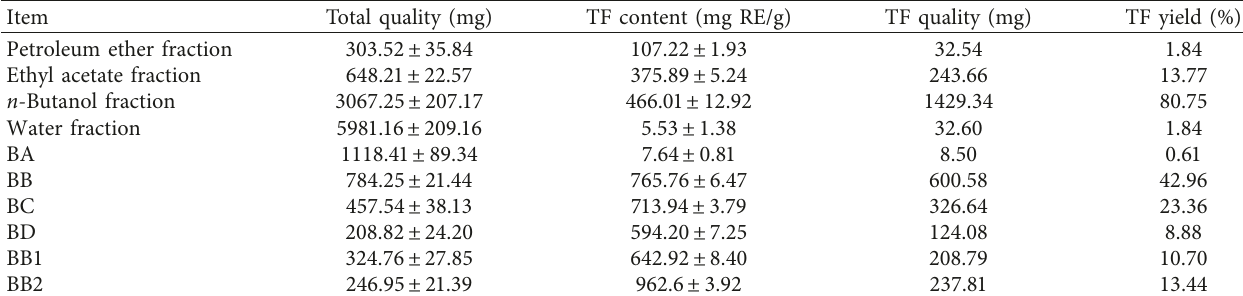
Table 1: Total quality, TF purity, TF quality, and TF yield of isolated